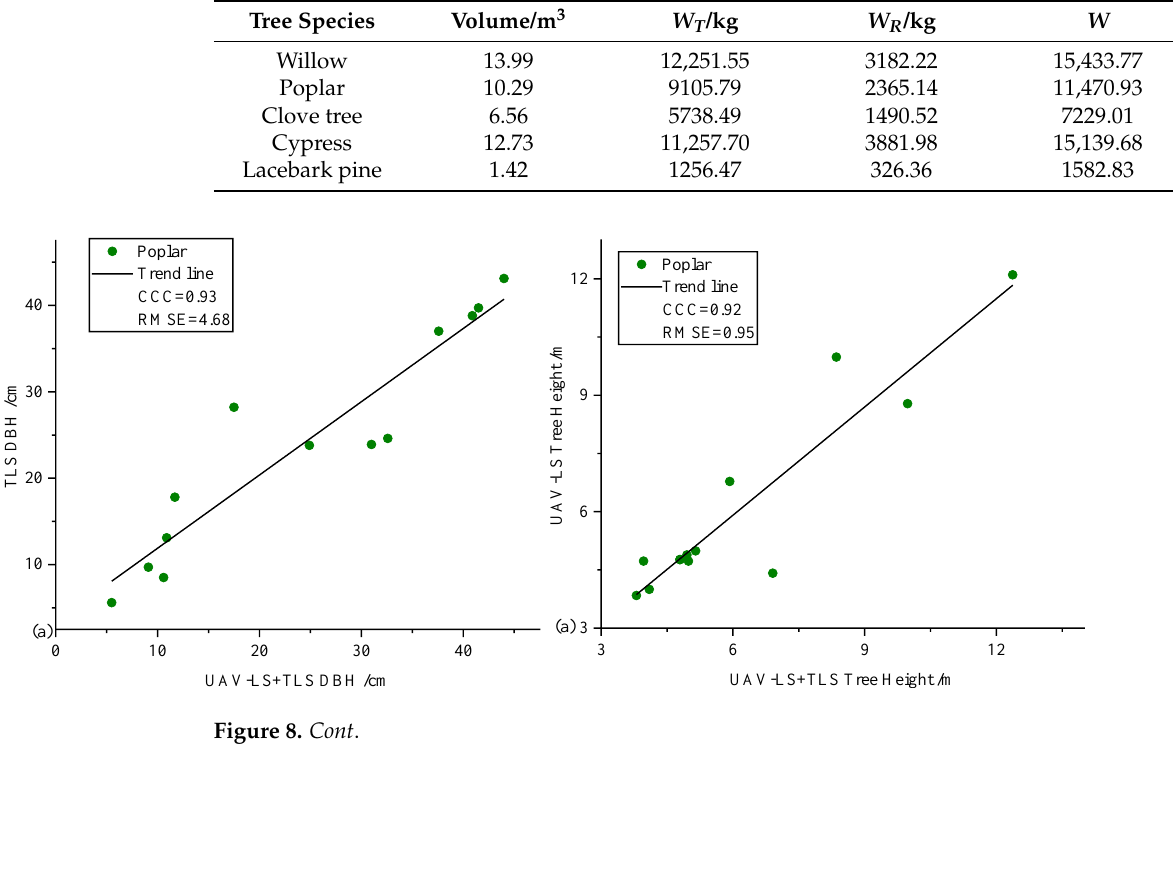
Table 8. Calculation results of tree species biomass. Tree Species